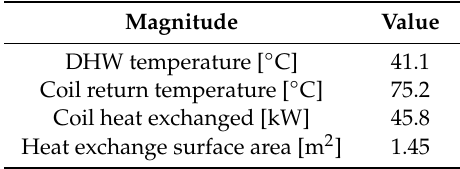
Table 2. Results of the steady simulation of continuous water